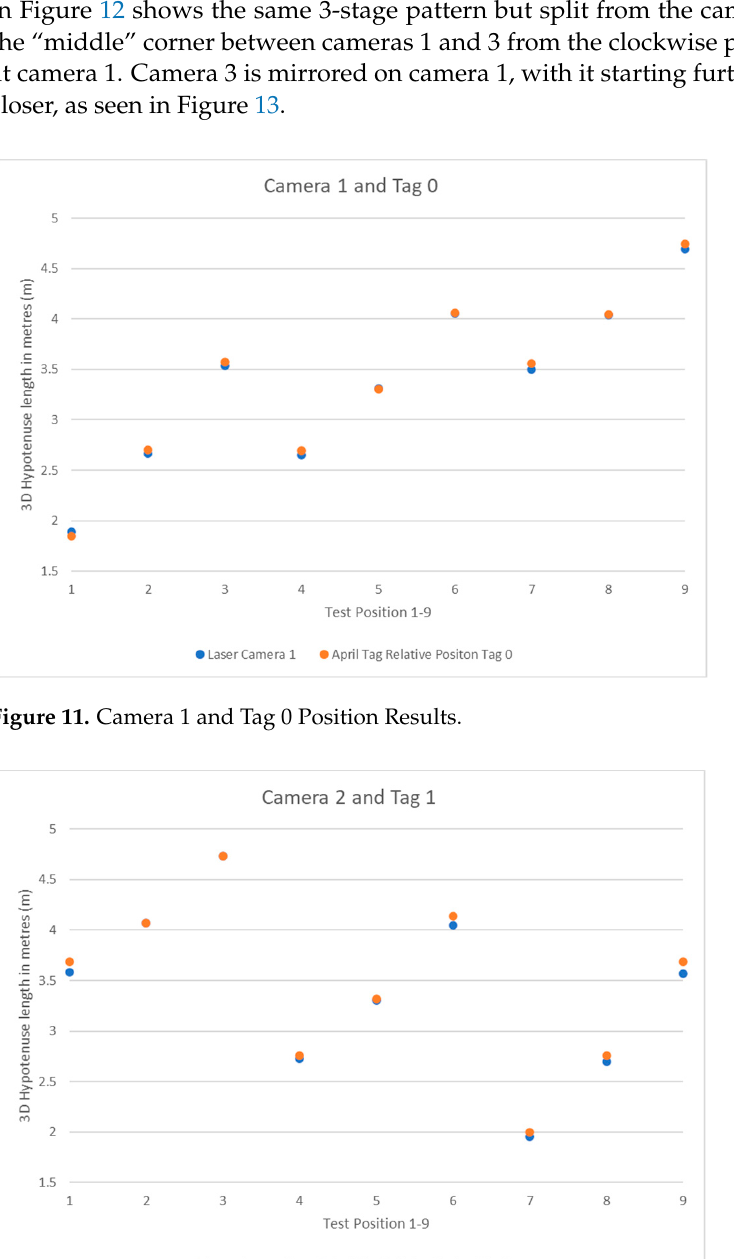
Figure 10. Layout of space.